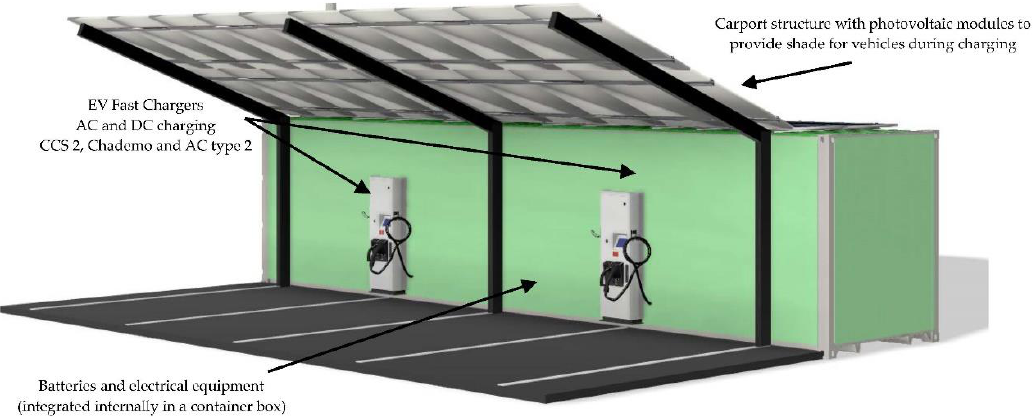
Figure 2. EV fast charging stations integrated with the PV solar generation and energy storage sys- tem.